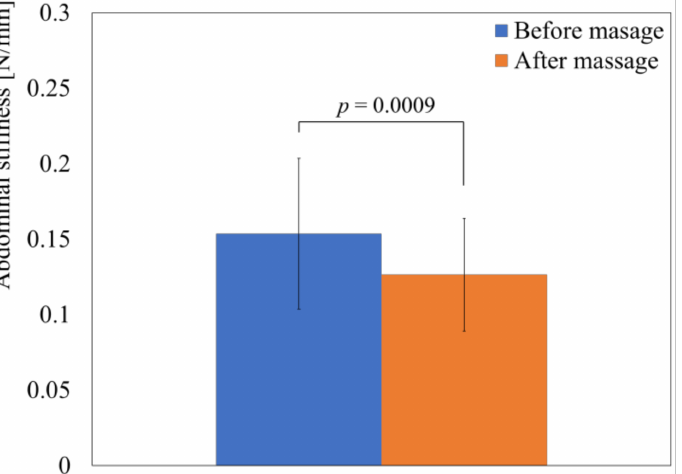
Figure 10. Evaluation results for abdominal stiffness. Error bar indicates standard deviation, and p -value shows results when performing t -test for paired